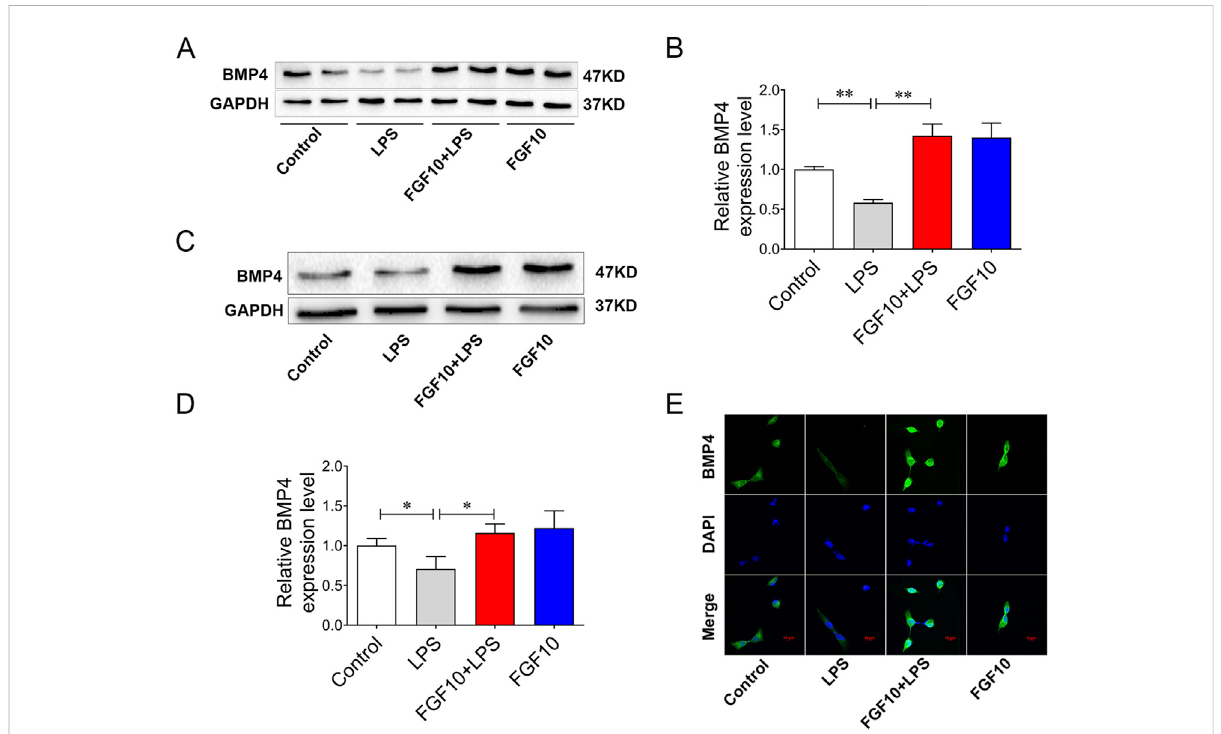
FIGURE 4 FGF10 promotes the expression of BMP4. (A) The expression of BMP4 in mice was detected by Western blotting. (B) Quantitative analysis of BMP4protein. (C) TheexpressionofBMP4inAECswasdetectedbyWesternblotting. (D) Quantitativeanalysis ofBMP4 protein. (E) BMP4 expression (green) of AECs was analyzed by immunostaining (magni fi cation ×400). The data werepresented as themean ± SEM, n = 3 – 5. * p < 0.05, ** p <